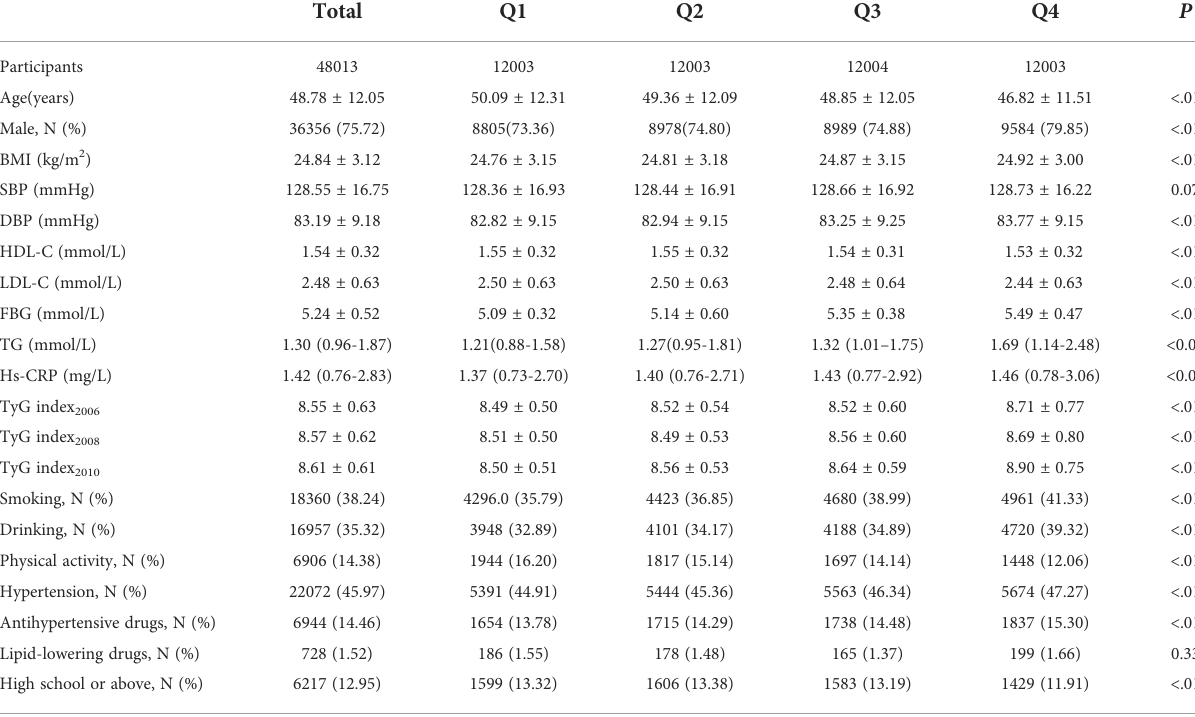
TABLE 1 Baseline characteristics of participants by TyG index variability quartiles